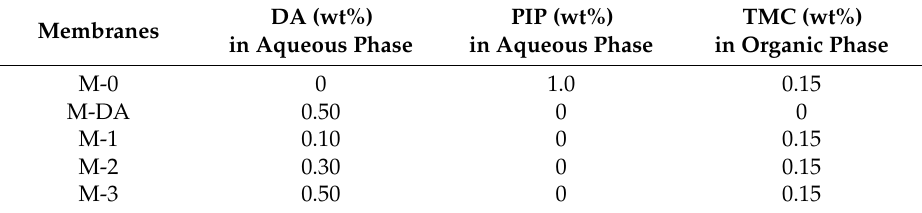
Table 1. Reagents for thin-film composite (TFC) Membranes Preparation. DA Membranes